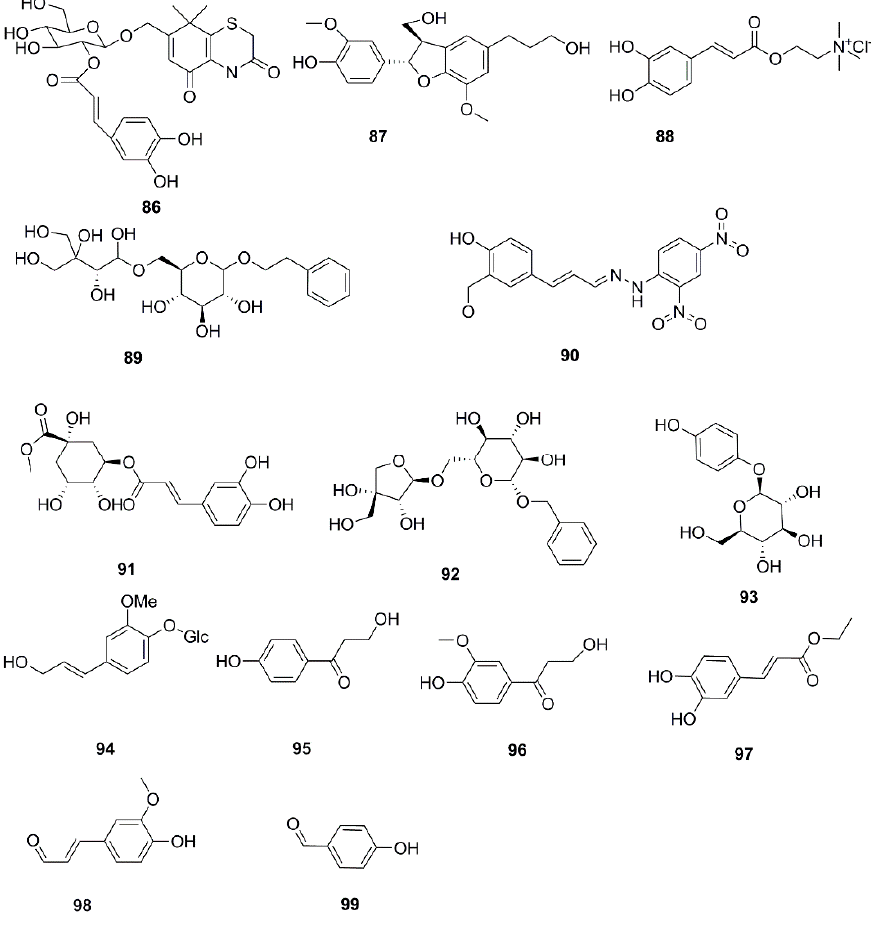
Figure 4. Chemical structures of the phenylpropenoids in X. strumarium.